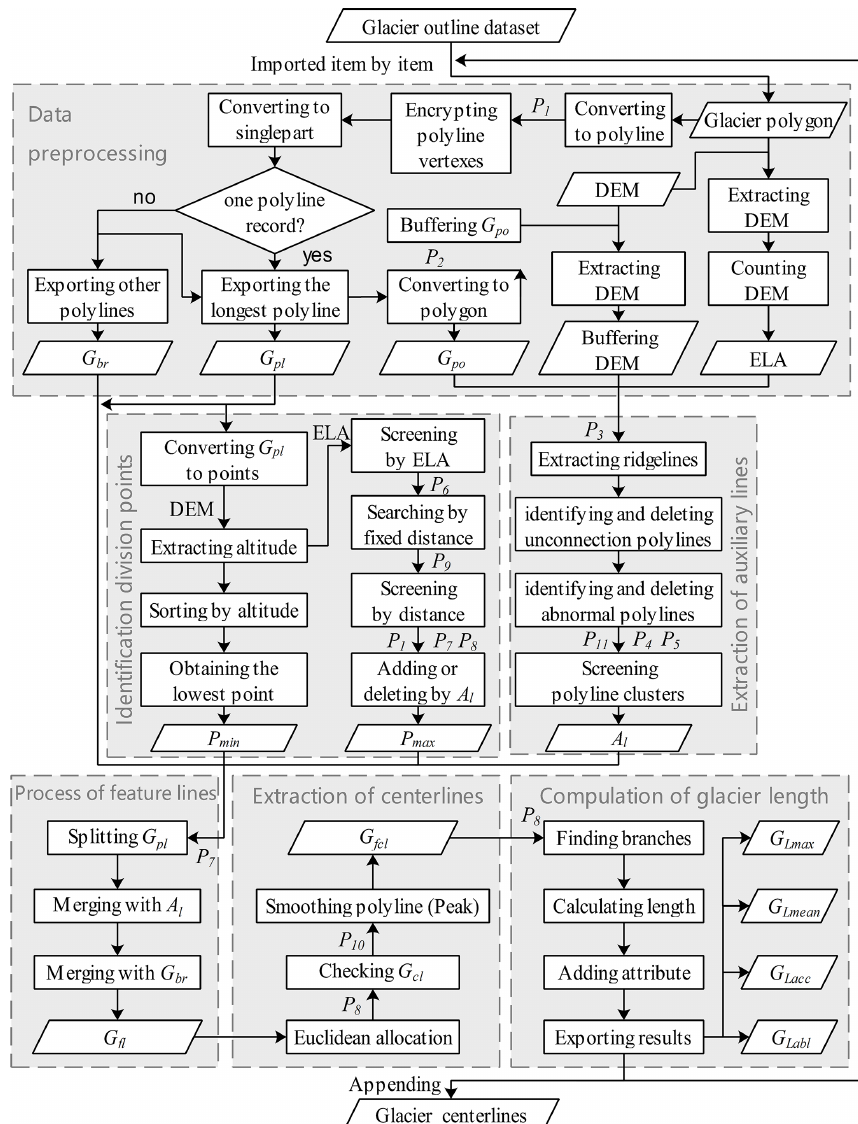
Figure 2. The flow chart of